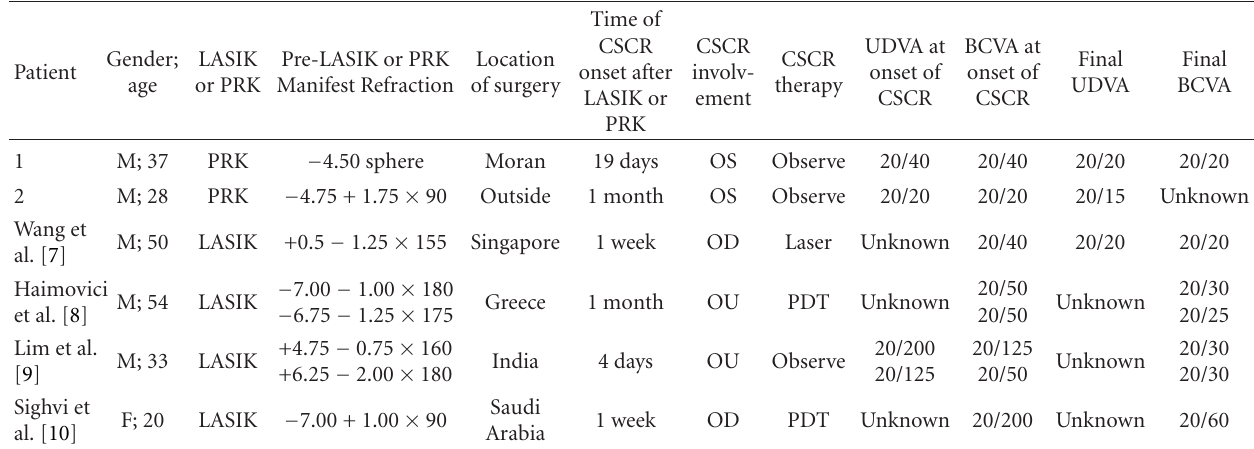
Table 1: Baseline and clinical data of CSCR patients with a history of LASIK or